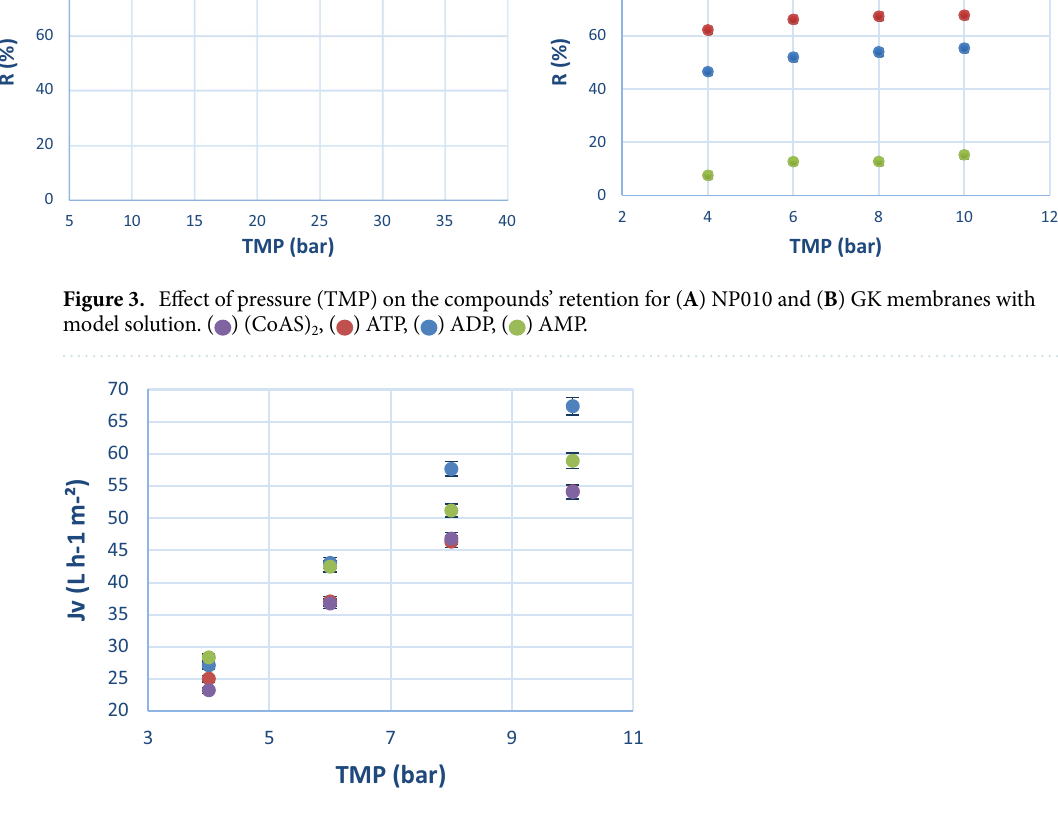
Figure 4. Effects of concentrations on permeate flux (Jv) as a function of transmembrane pressure (TMP). ( ) 1.51 g L −1 , ( ) 2.43 g L −1 , ( ) 5.19 g L −1 , ( ) 10.71 g L −1